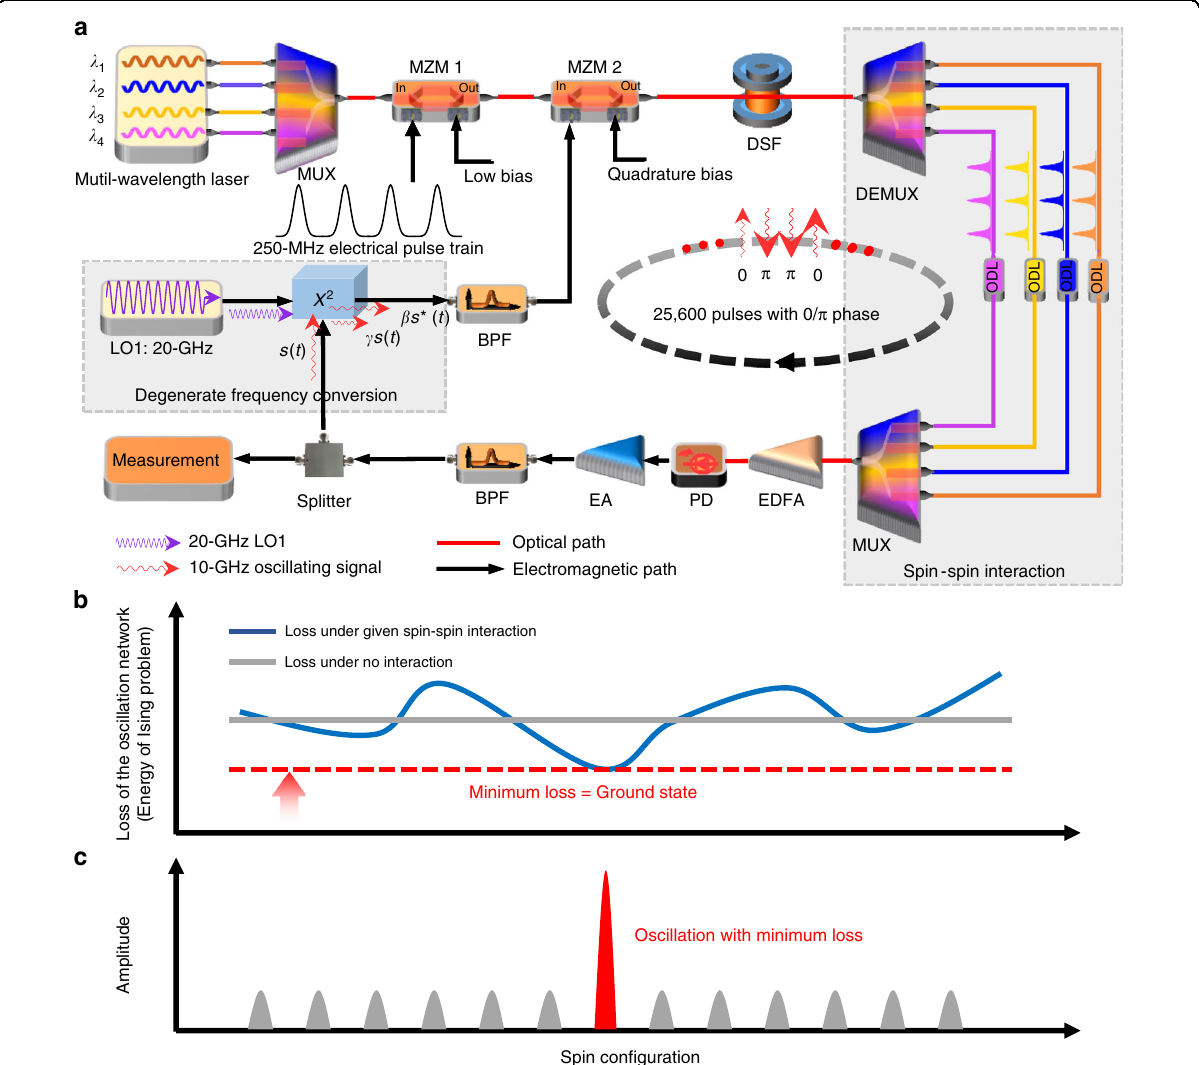
Fig. 1 The schematic diagram and operation principle of the proposed OEPO-based Ising machine. a The schematic diagram. Spins are represented as binary phases of short microwave pulses generated from the OEPO, and spin interactions are realized by using different channels in the optical path with con fi gurable delays. MZM Mach-Zehnder modulator, DSF dispersion-shifted fi ber, MUX multiplexer, ODL optical delay line, DEMUX demultiplexer, EDFA Erbium-doped fi ber ampli fi er, PD photodetector, EA electrical ampli fi er, BPF bandpass fi lter, LO local oscillator. b A given spin-spin interaction would change the global network loss, and the minimum-loss operation can be achieved by gradually increasing the gain of the OEPO network. c The network with the minimum-loss spin con fi guration has the maximum possibility to oscillate, and the phase con fi guration corresponds to the answer to a given Ising